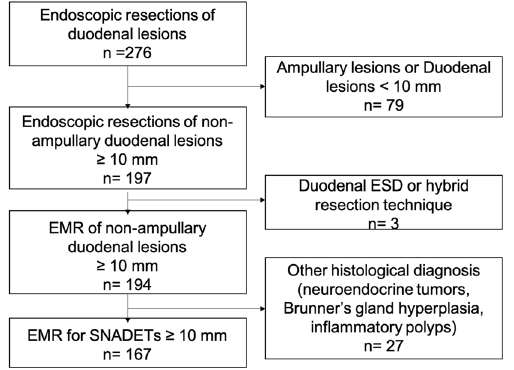
Figure 1. Study flowchart.